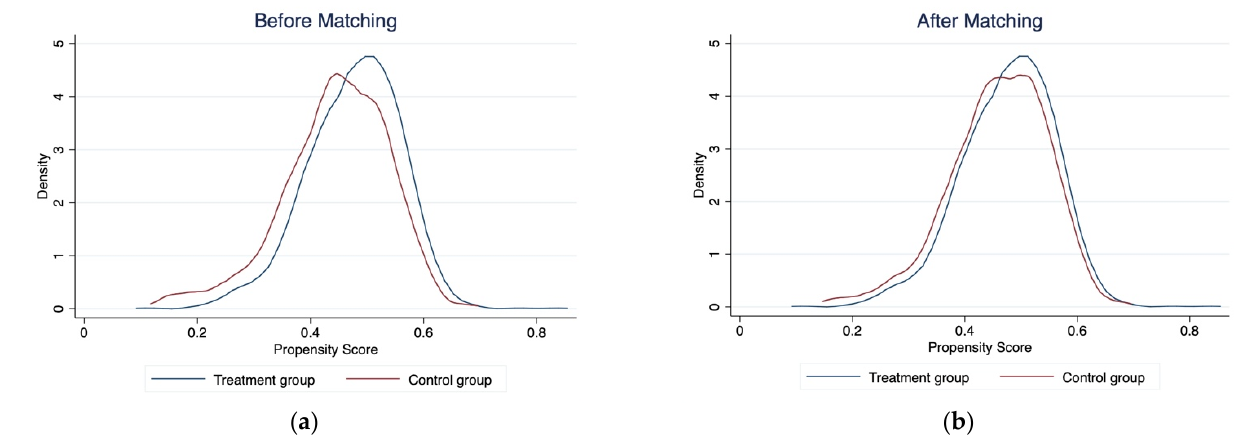
Figure 4. Kernel density plot of propensity scores before and after matching.